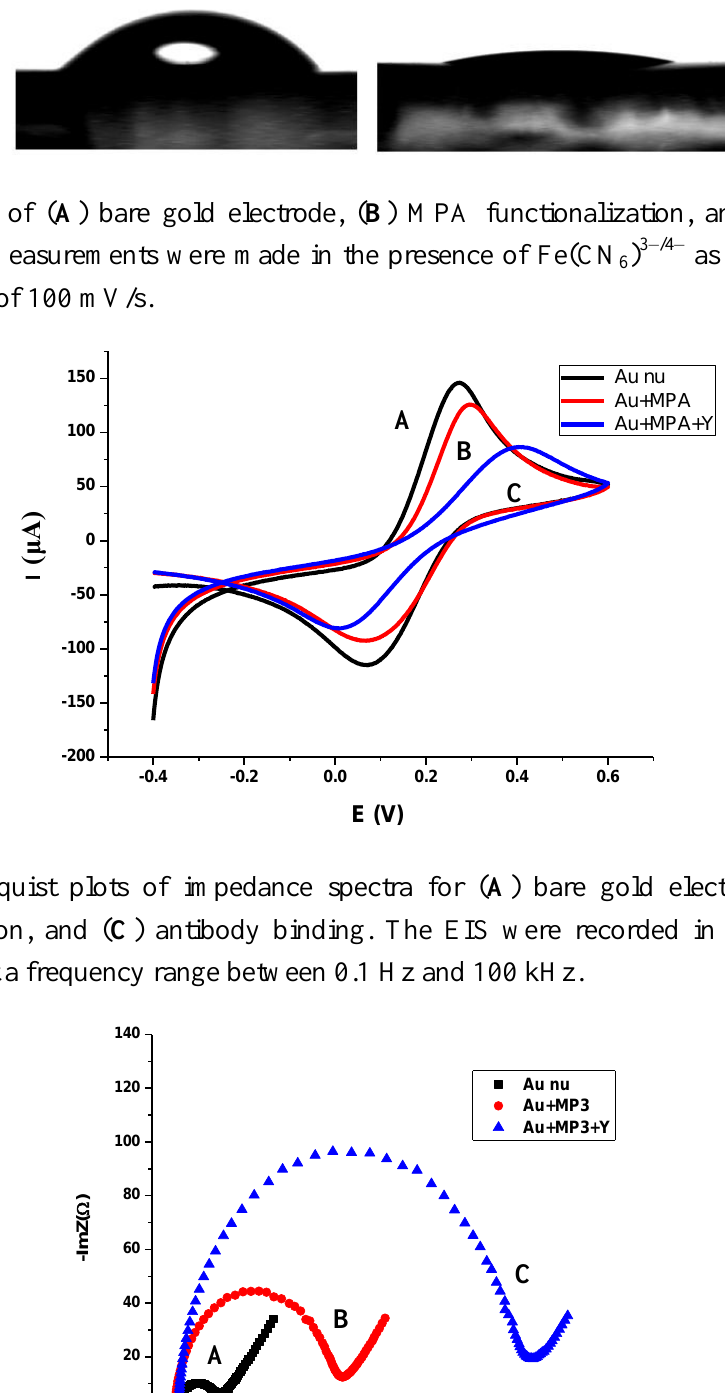
Figure 2. Contact angles and properties of MPA, where, ( A ) bare gold with the angle measured at 48.3 ± 1°, and ( B ) MPA monolayer with the angle measured at 7.4 ± 1°.